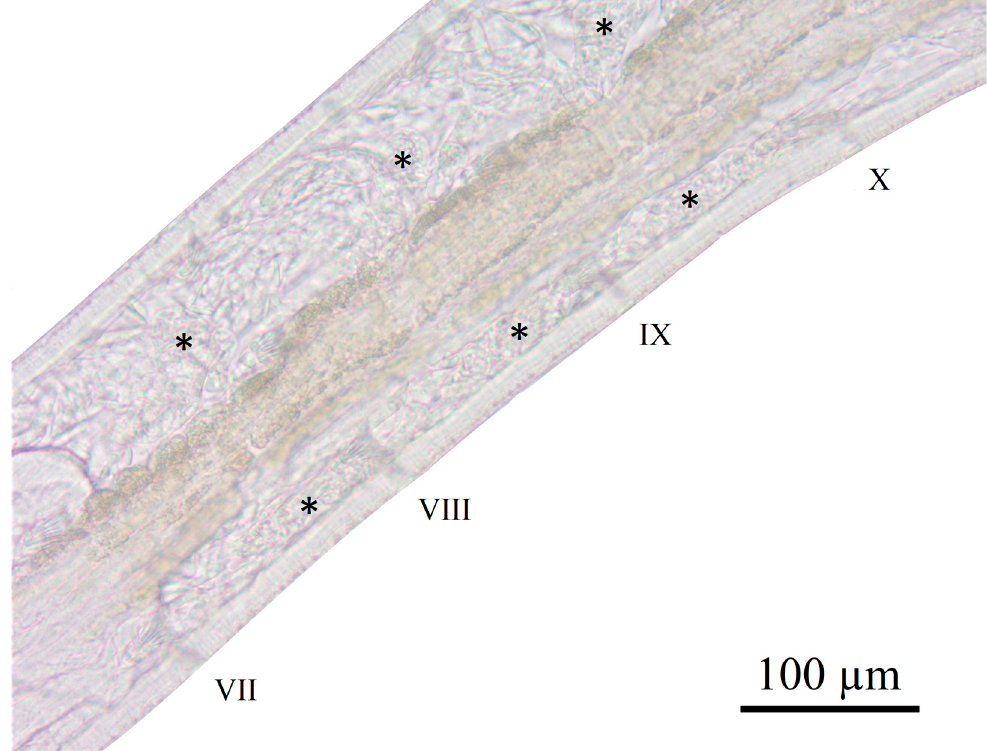
Figure 2. Fridericia gongalskyi sp. nov., subadult specimen, segments VII–X. All six preclitellar nephridia are marked with asterisks (*).